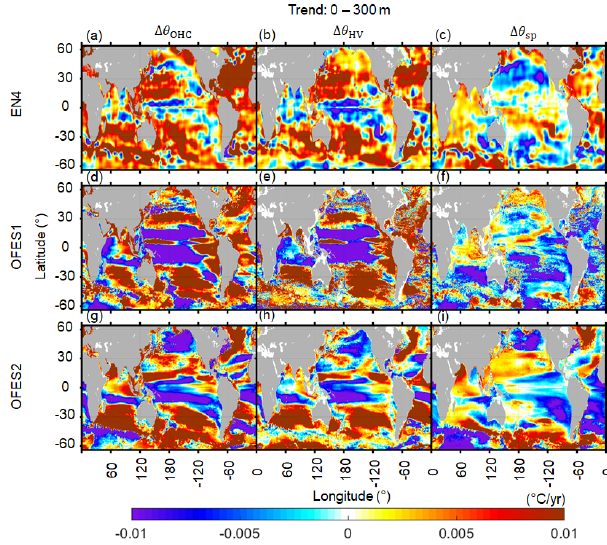
Figure 14. Spatial distributions of (cid:49)θ OHC (a, d, g) , (cid:49)θ HV (b, e, h) , and (cid:49)θ SP (c, f, i) , 1960–2016, in the top ocean layer (0–300m). Top to bottom: EN4, OFES1, and